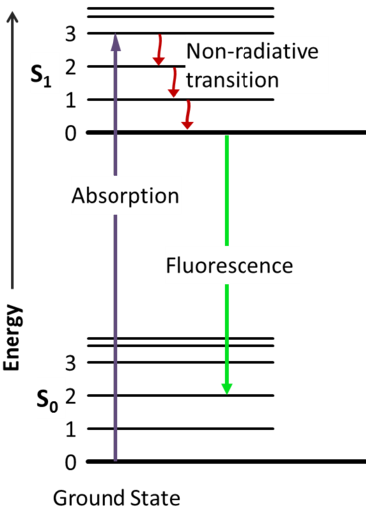
Figure 22. Jablonski diagram of changing electron states that enables fluorescent detection. From initial photonic absorption, through transition and eventual lower-energy photonic